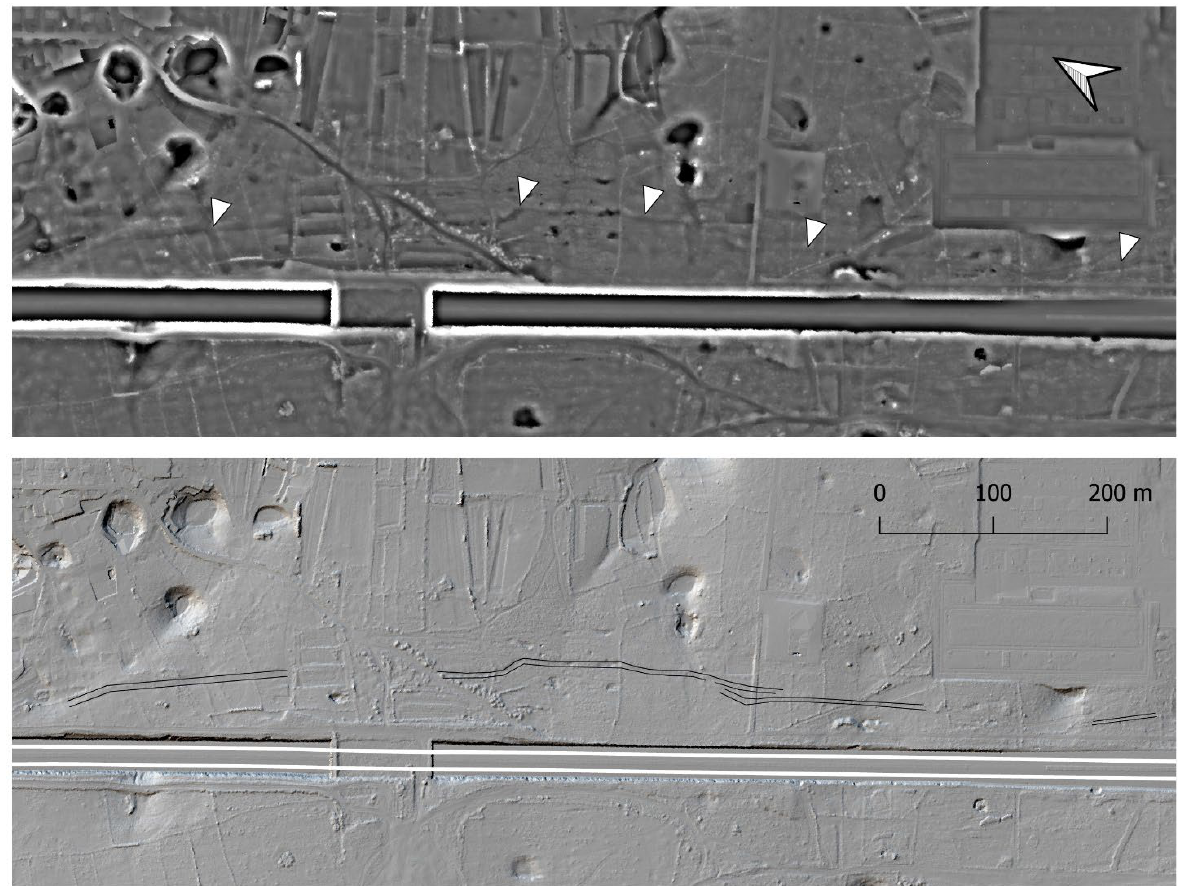
Figure 11. Zoomed view of area F of Figure 2 with the position of road tracks indicated by white arrows in the upper picture (local relief model of an ALS-derived DTM) and by black lines in the lower one (hill-shaded image of an ALS-derived DTM). Modern roads are indicated by white lines.